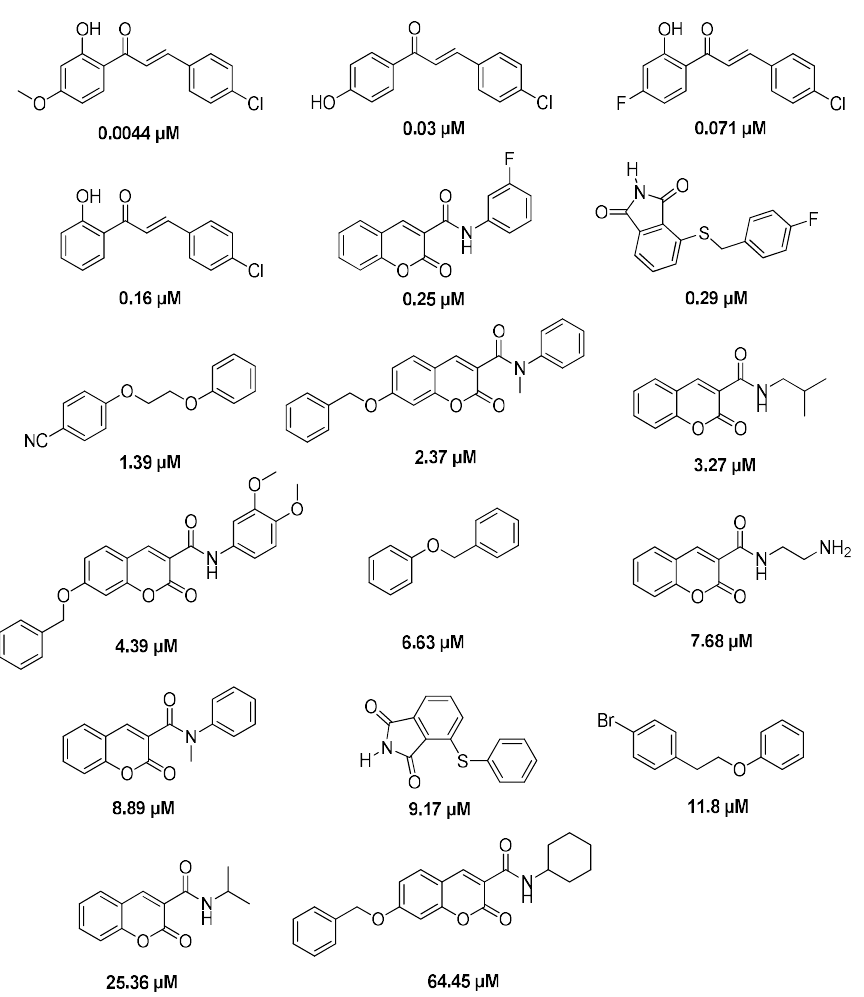
Figure 5. Training set compounds and their activity